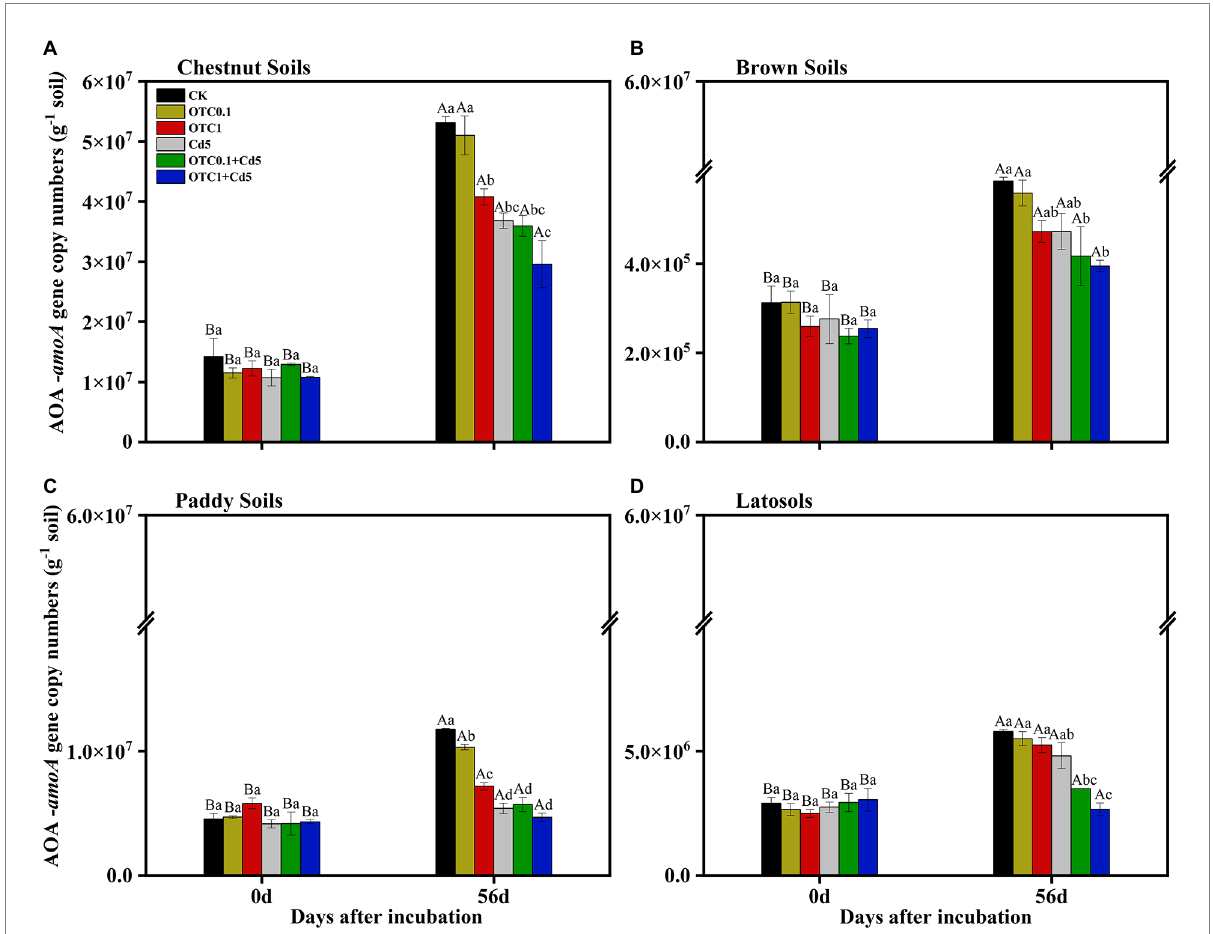
FIGURE 3 Abundance of AOA amoA gene in chestnut soils (A) , brown soils (B) , paddy soils (C) , and latosols (D) under CK, OTC0.1, OTC1, Cd5, OTC0.1 + Cd5, and OTC1 + Cd5 treatments at day 0 and day 56. The vertical bars indicated the standard errors of the mean of triplicate samples. Different lowercase letters above the error bars indicated significant differences among treatments ( p < 0.05). Different uppercase letters above the error bars indicated significant differences among sampling time points under the same treatment ( p < 0.05). CK, control treatment without